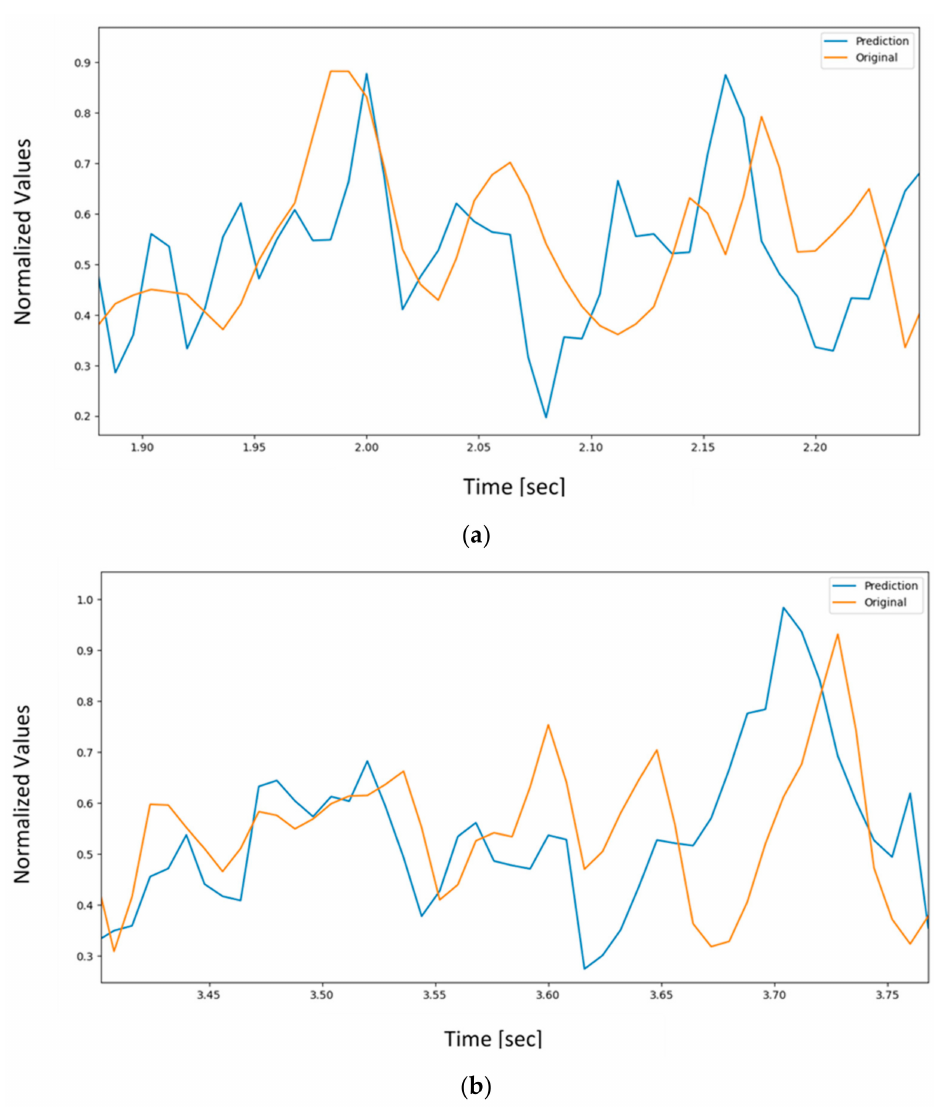
Figure 31. ( a ) A close-up of Figure 30 from 1.90 to 2.25 s; ( b ) close-up of Figure 30 from 3.4 to 3.8